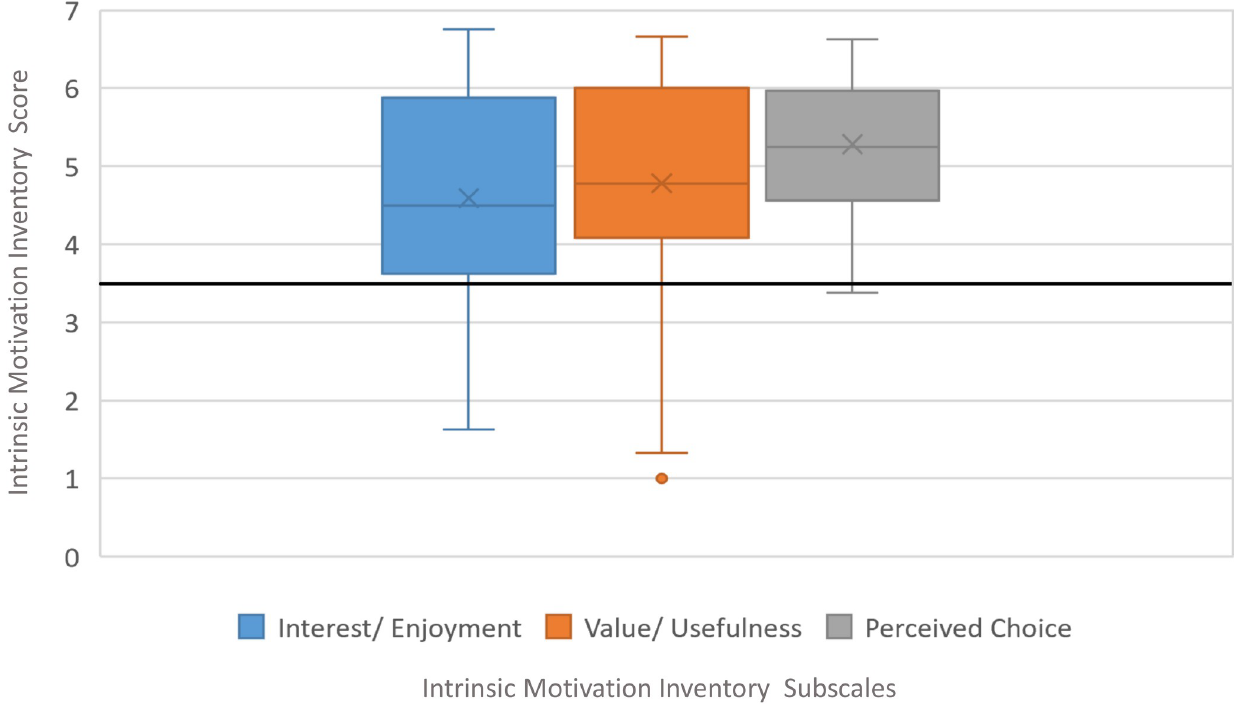
Fig 4. Boxplot distribution of IMI assessment: Interest/Enjoyment, Value/Usefulness, perceived choice.